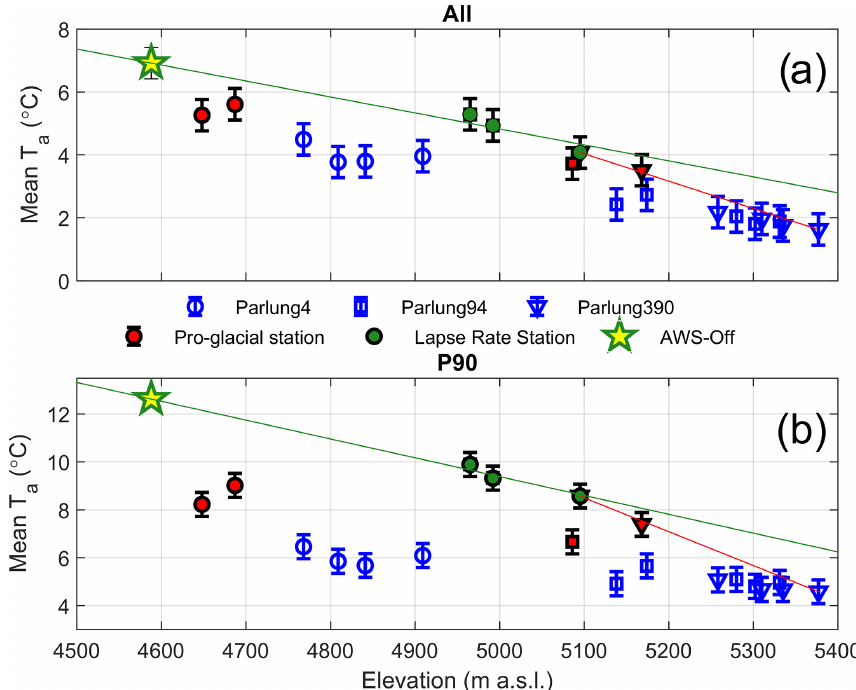
Figure 4. The mean T a against elevation for all hours (a) and P90h (b) , where blue markers are on-glacier T loggers, red markers are pro-glacial T loggers and green circles denote off-glacier T loggers used to construct an hourly variable catchment lapse rate (green line), extrapolated from AWS_Off (star). The red line indicates the piecewise lapse rate above the elevation of T 1 390 to lapse T a to the top of the flowline. A 0.5 ◦ C uncertainty is shown by the error bar for each station (not applied to the lapse rate for